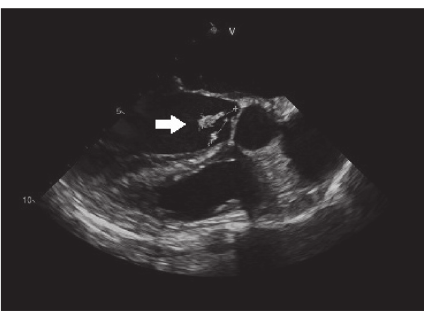
Figure 1: TEE midesophageal long axis view demonstrating mobile vegetation on the aortic valve measuring at 10mm × 6